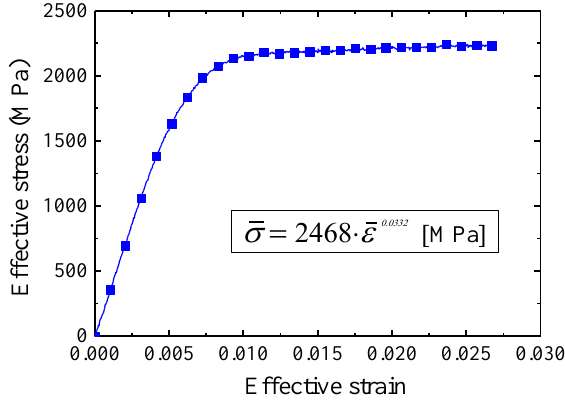
Figure 3. Flow stress curve of the initial rhodium wire. Table 1. Mechanical properties of the initial rhodium wire.